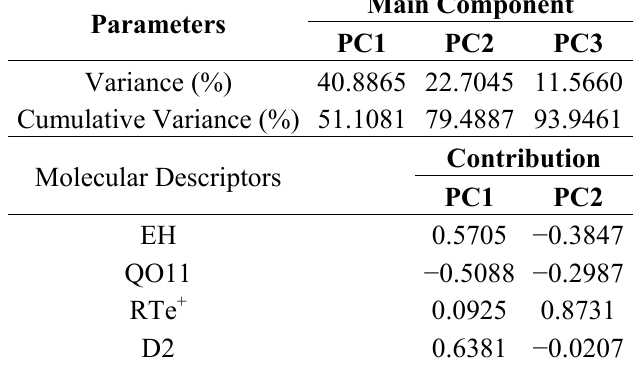
Table 4. Principal component analysis of the SAR model and contribution of selected descriptors based on step multivariate analysis.